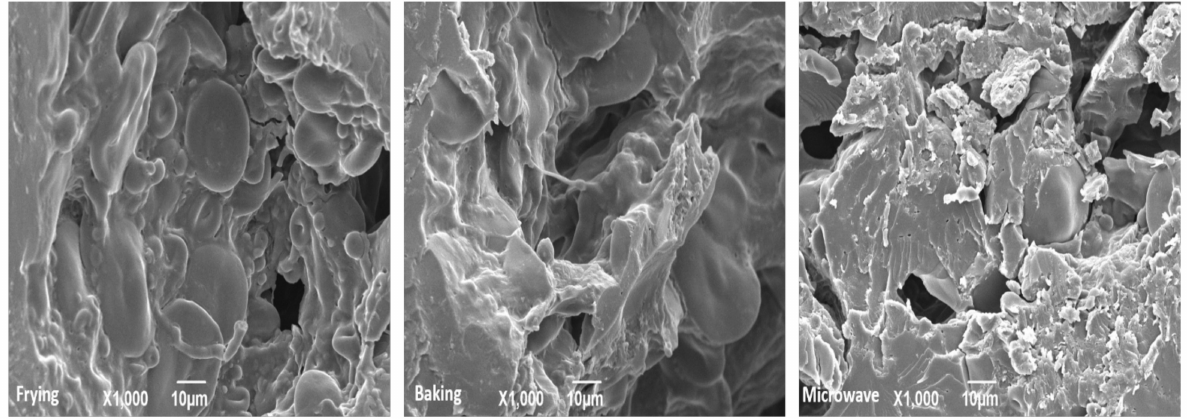
Figure 5. Microstructural analysis of fish meat-based snacks prepared by various processing